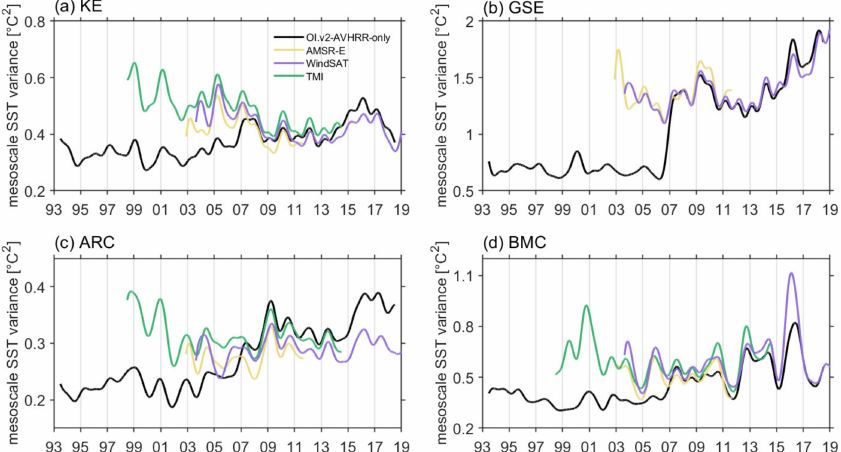
Figure 5. Time series of the 1.5-year low-pass filtered mesoscale SST variance in the ( a ) KE, ( b ) GSE, ( c ) ARC, and ( d ) BMC regions. The black, yellow, purple, and green lines denote the value based on the OI.v2-AVHRR-only data, AMSR-E data, WindSAT data, and TMI data,